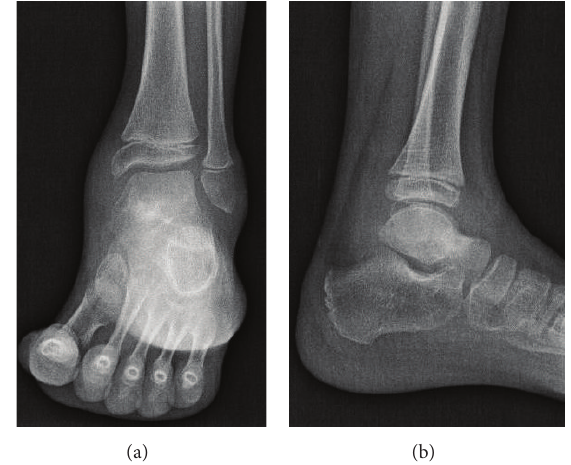
Figure 3: 8-year-old boy with osteoid osteoma of the left talar neck. Synovial thickening of the ankle and subtalar joint was diagnosed with echography. X-ray showed ankle effusion but no bone anomaly was initially reported. However retrospective X-ray analysis showed a talar neck